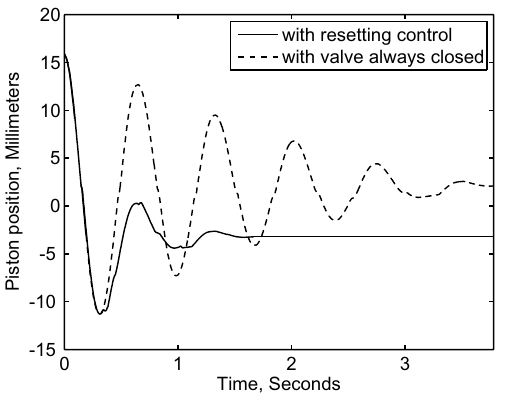
Fig. 7. Response of pendulum system with resetting control logic turned on (solid) and off (dotted). The offset shown is due to Coulomb